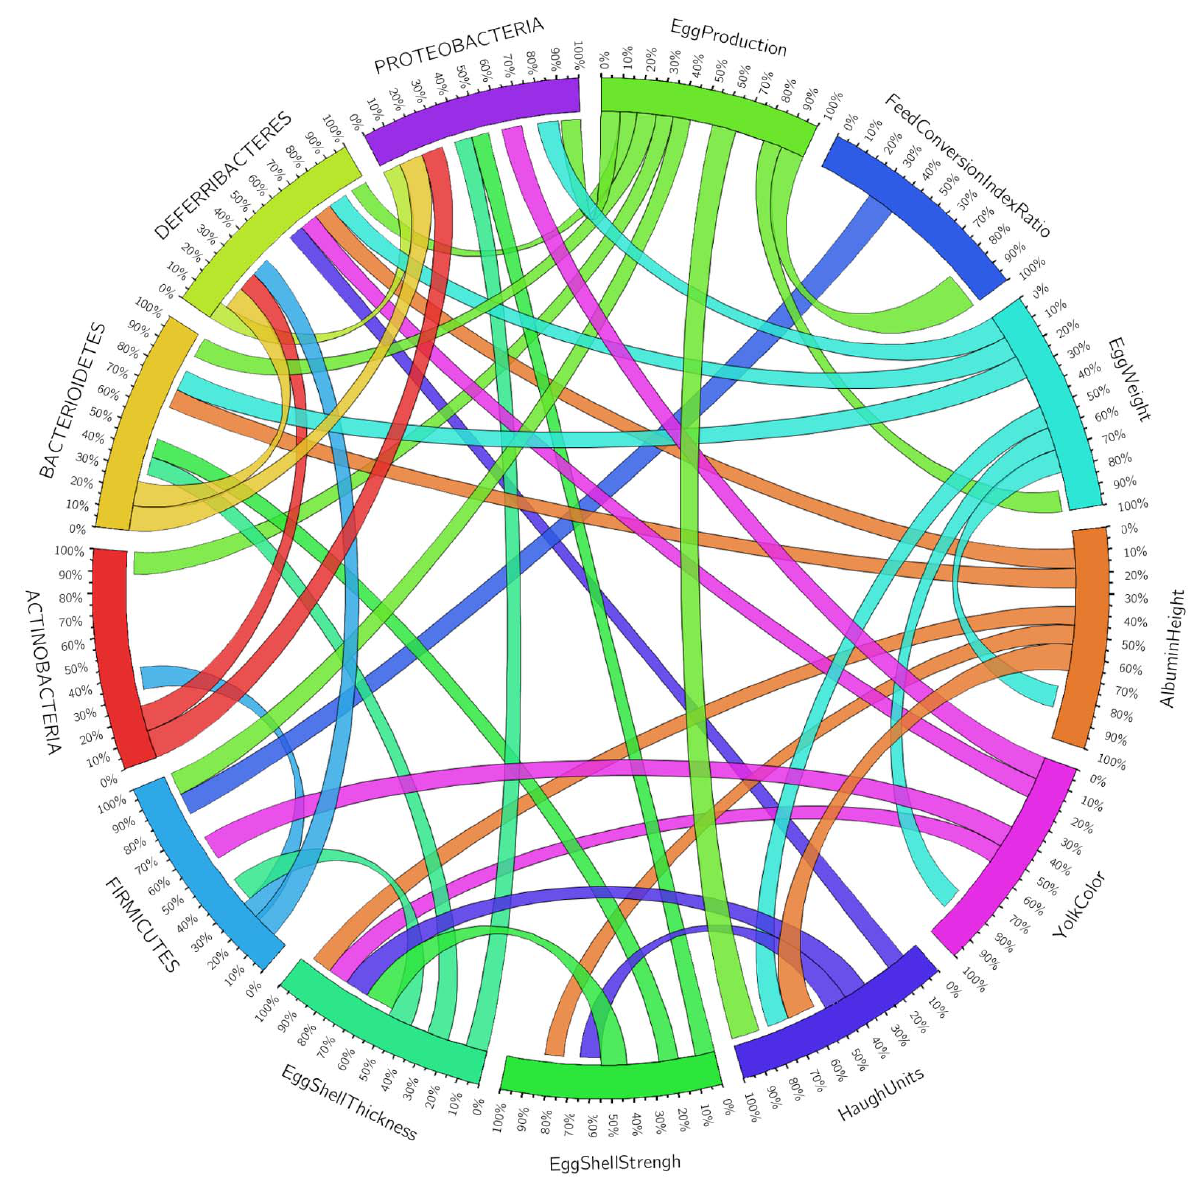
Figure 4. Schematic representation of the Pearson correlations ( p > 0.05) between the relative abun